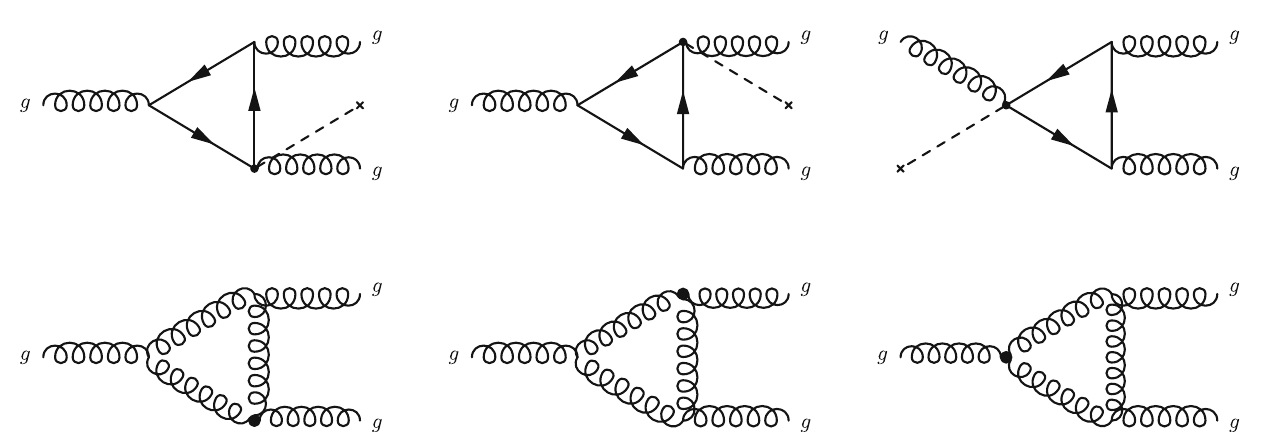
Fig. 12 1PI diagrams contributing to the ggg 3-point function. Of course, there are also diagrams with only two propagators for both the insertion of the Weinberg and the dipole operator, but we find that these